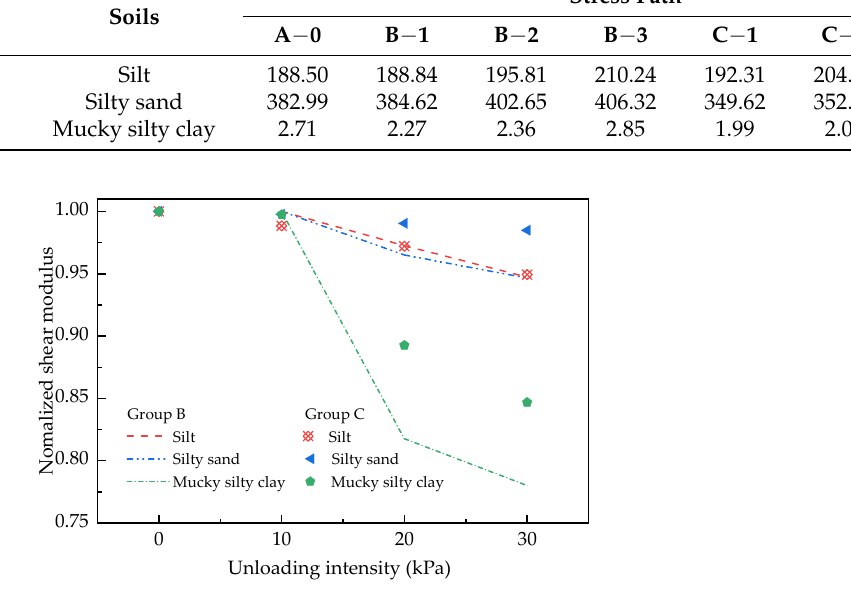
Figure 11. Normalized permeability coefficient-unloading intensity relationship of three soils in Figure 10. Normalized small-strain shear modulus–unloading intensity relationship of three soils different stress under different stress paths.